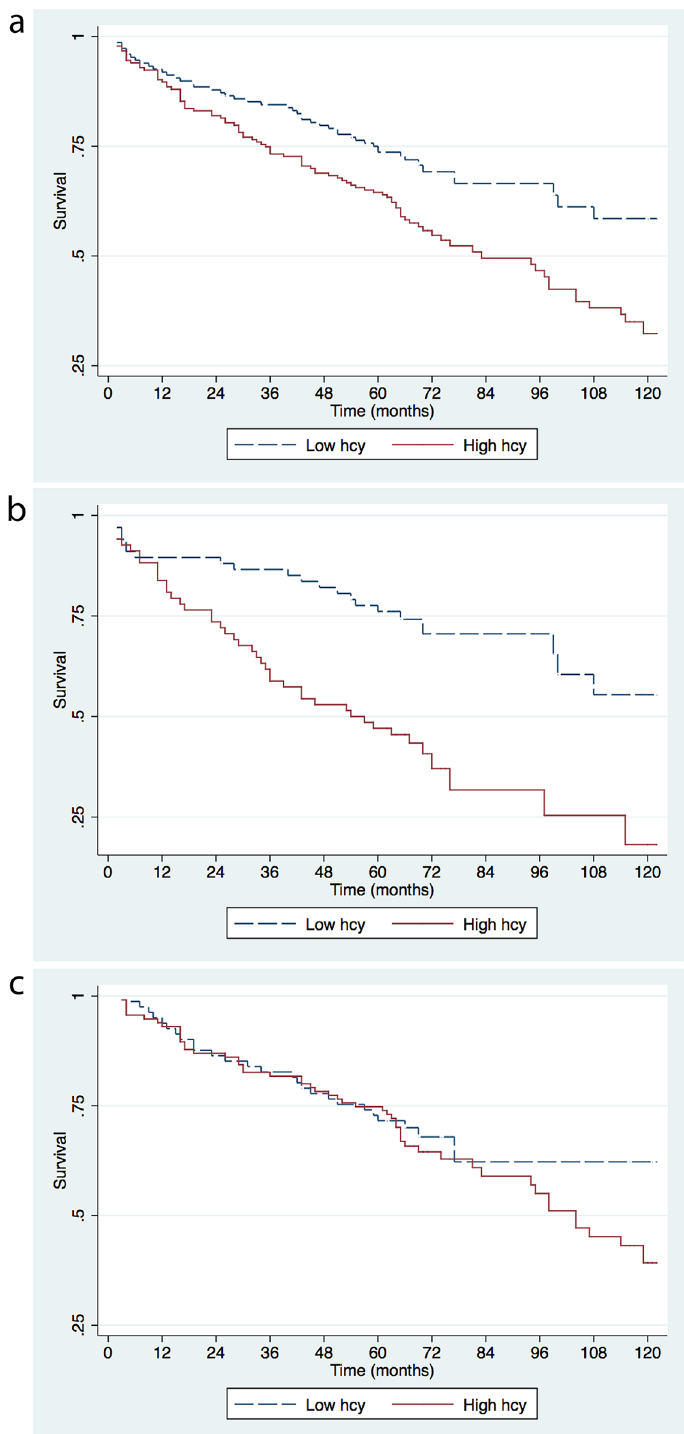
Fig 1. Kaplan-Meier survival curves for 10-yearobservation of 1-month survivorsby tHcy status. The analyseswere performed for all patients (a), for women (b), and men (c).